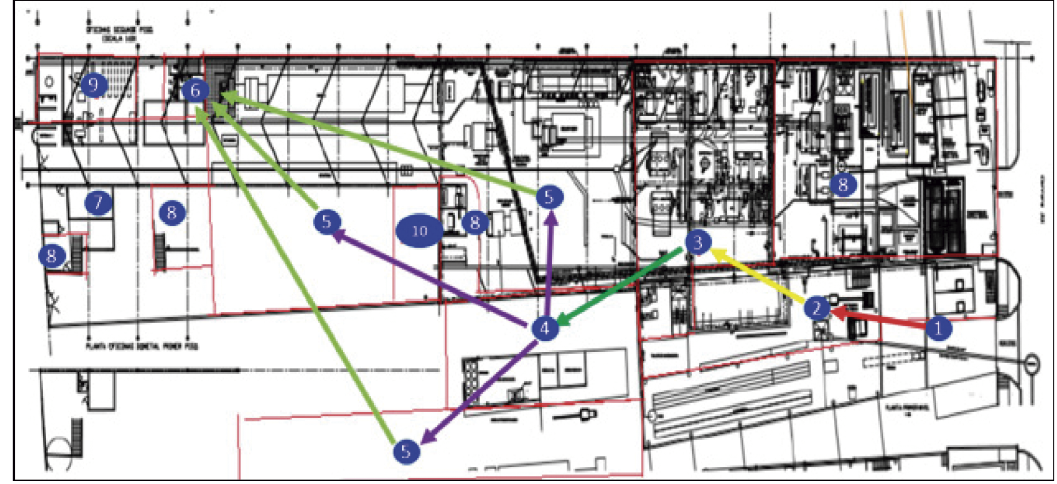
Figure 1. Physical Layout - case